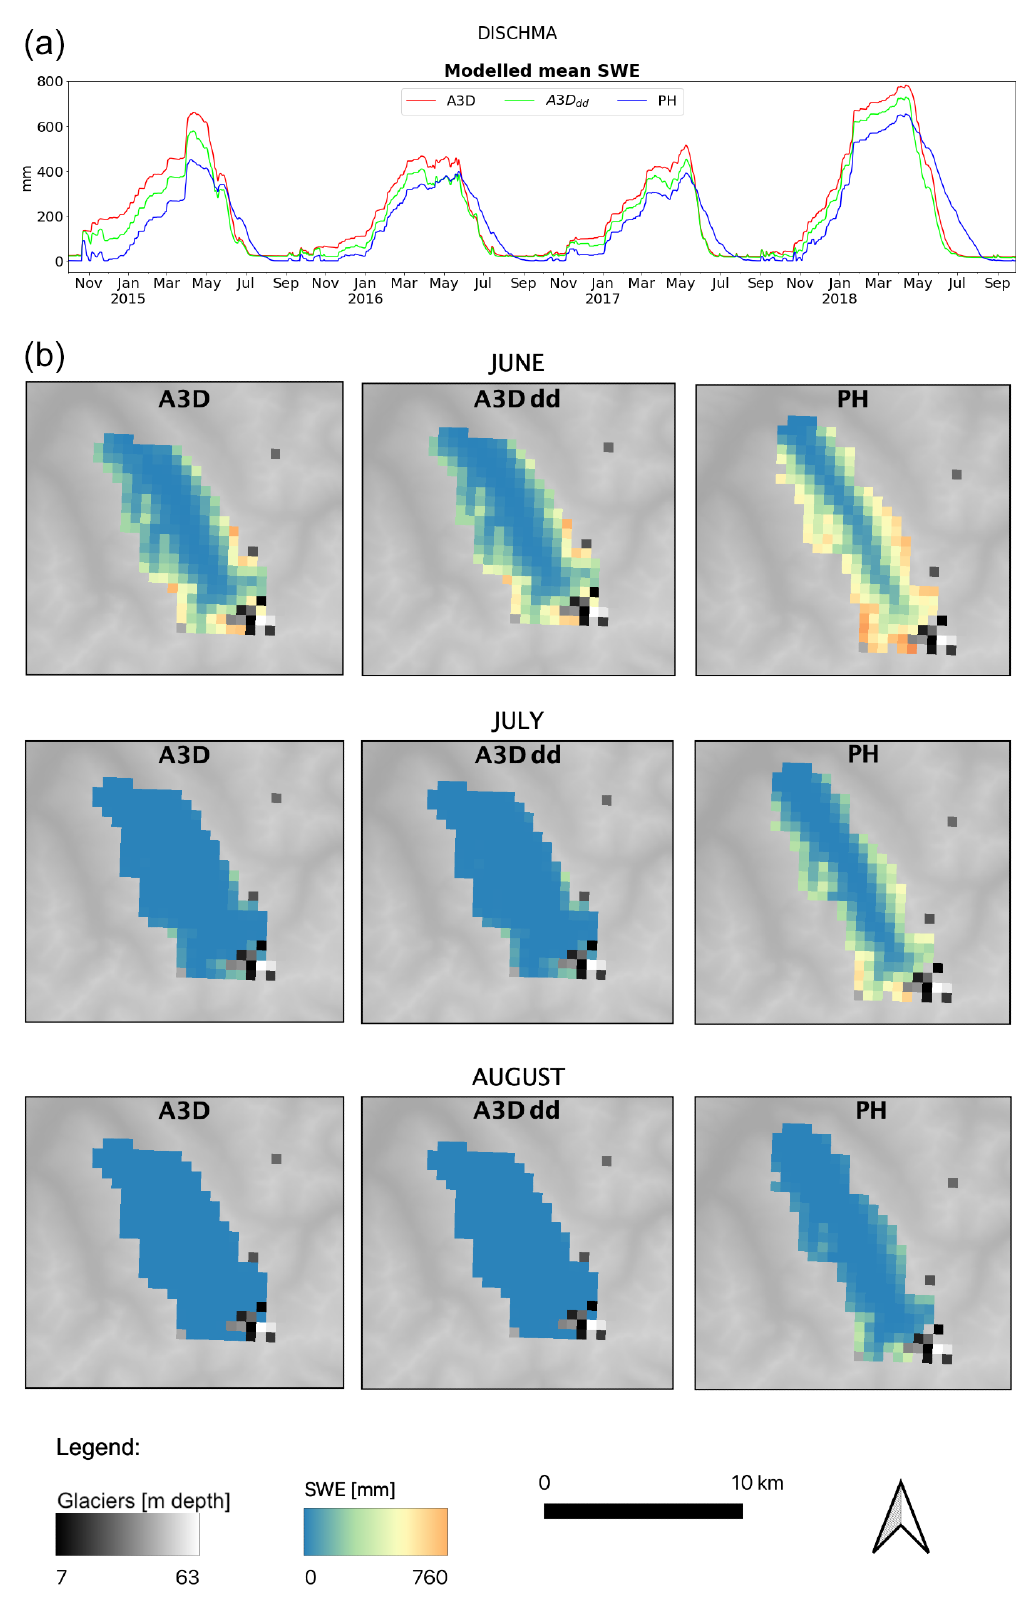
Figure 5. (a) Modelled mean SWE over the Dischma basin for the validation period. (b) SWE maps for summer months over the Mera basin for the calibration and validation